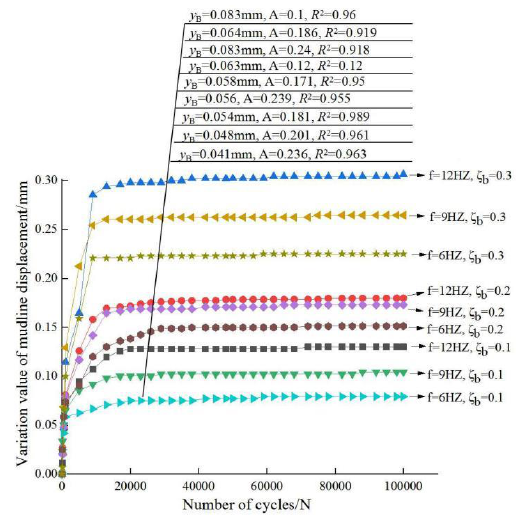
Figure 7. Variation of displacement at the tower top. Notes: The fitting data are consistent with the measured curves from top to bottom and no fitting curve is drawn.